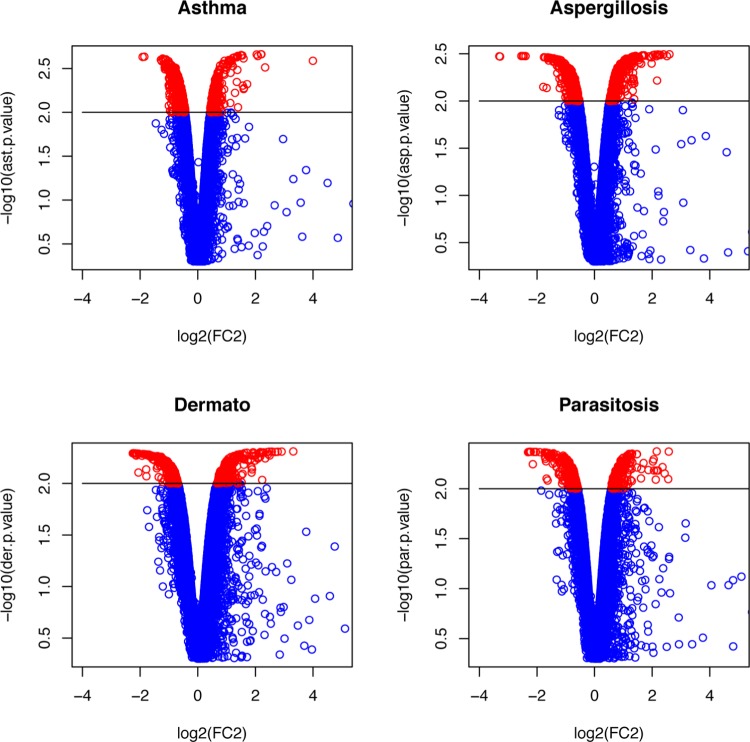
Differentially expressed genes in unrelated hypereosinophilic diseases.Volcano plot of genes differentially expressed between subjects with peripheral hypereosinophilia (i.e. asthma, dermatological disease, parasitosis and pulmonary aspergillosis) vs. healthy controls. Genes with a p-value <0.01 are depicted in red.